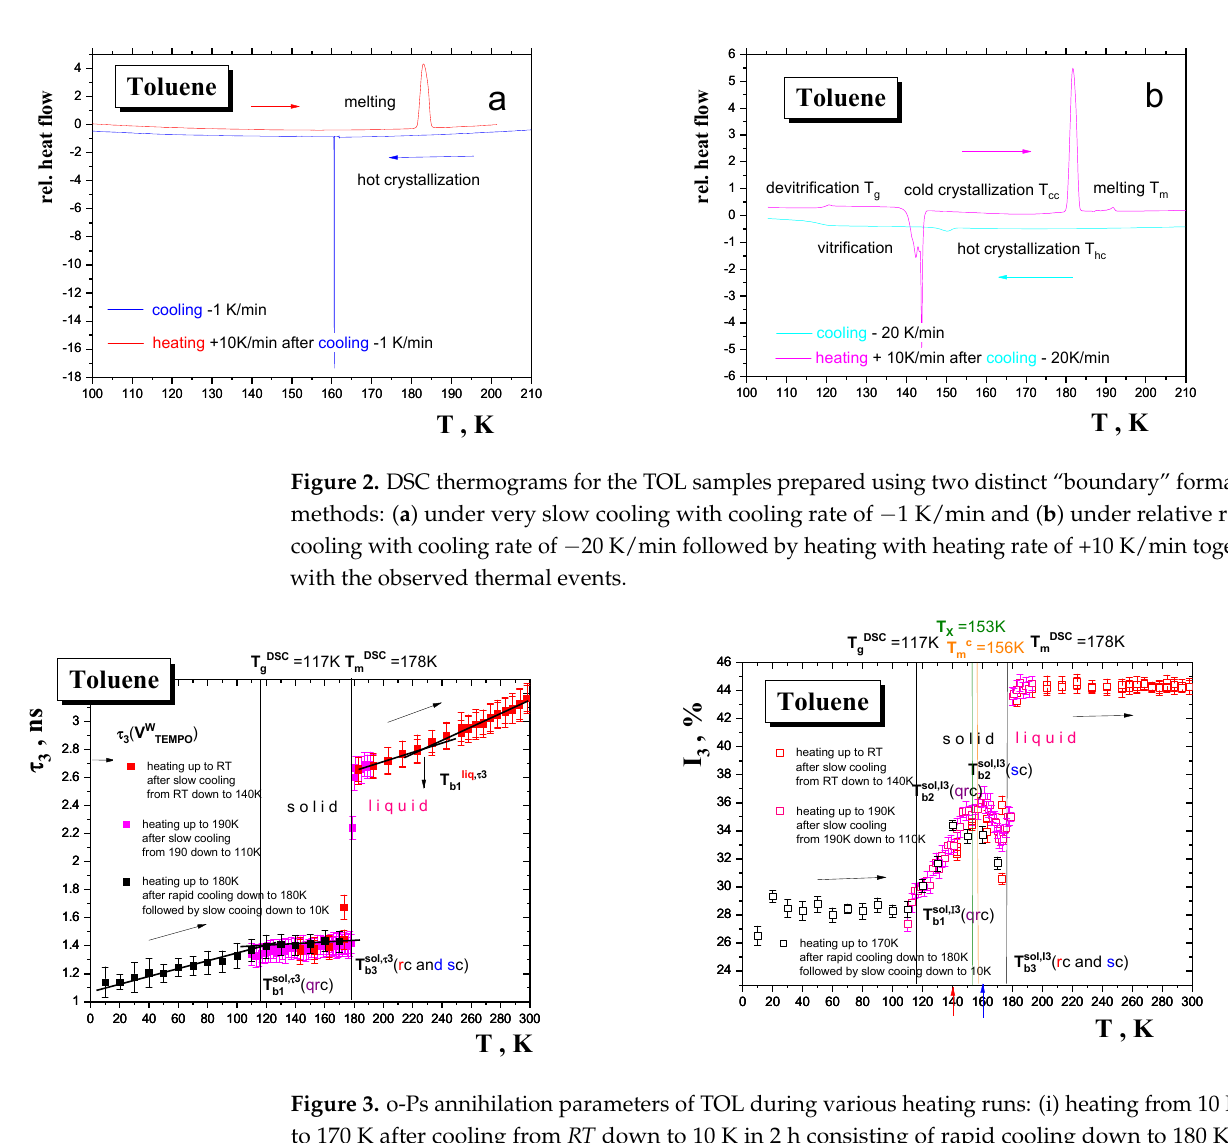
Figure 2. DSC thermograms for the TOL samples prepared using two distinct “boundary” formation